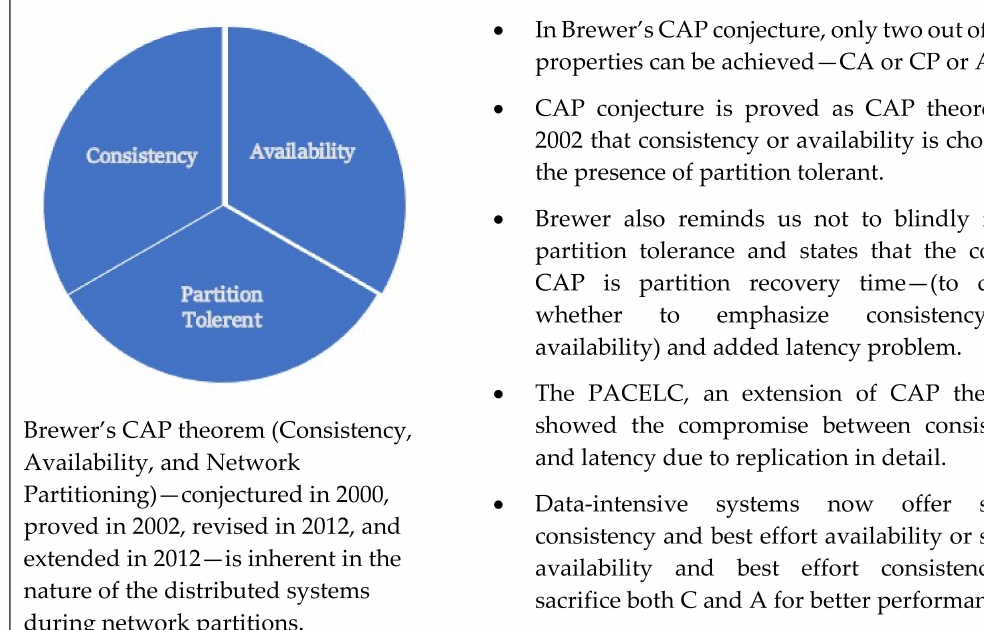
Figure 3. CAP Theorem and its